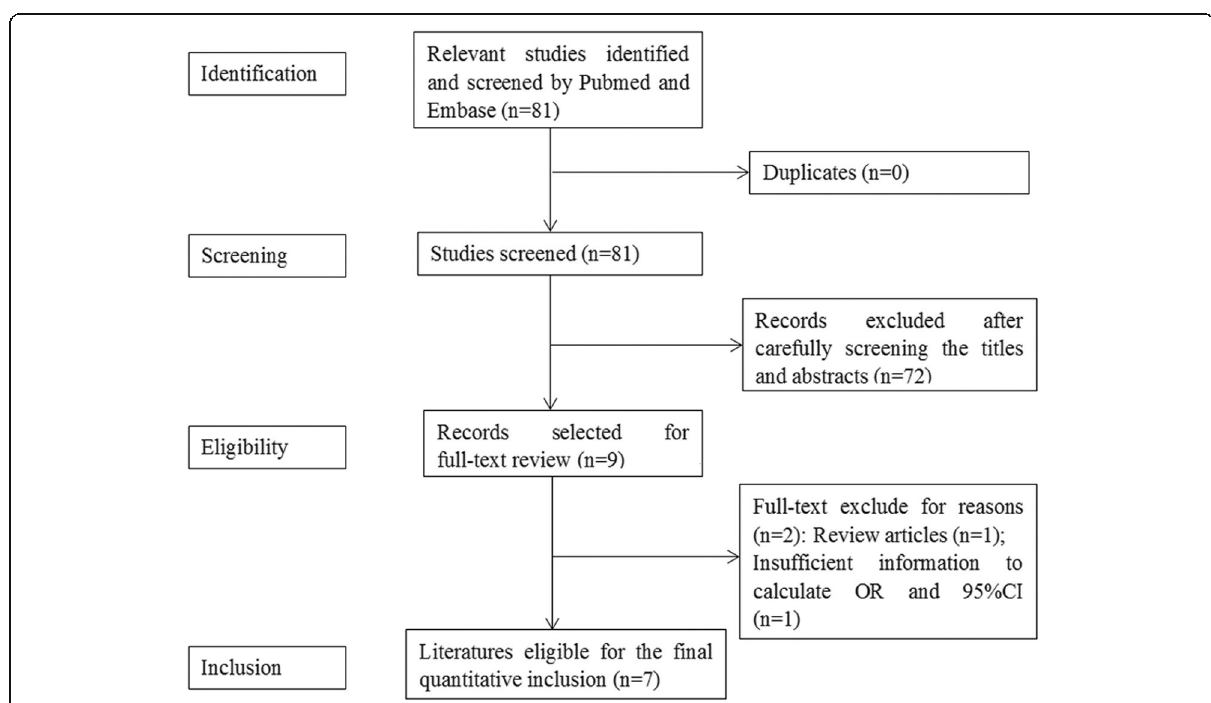
Fig. 1 Flow diagram for identification of eligible studies for this meta-analysis